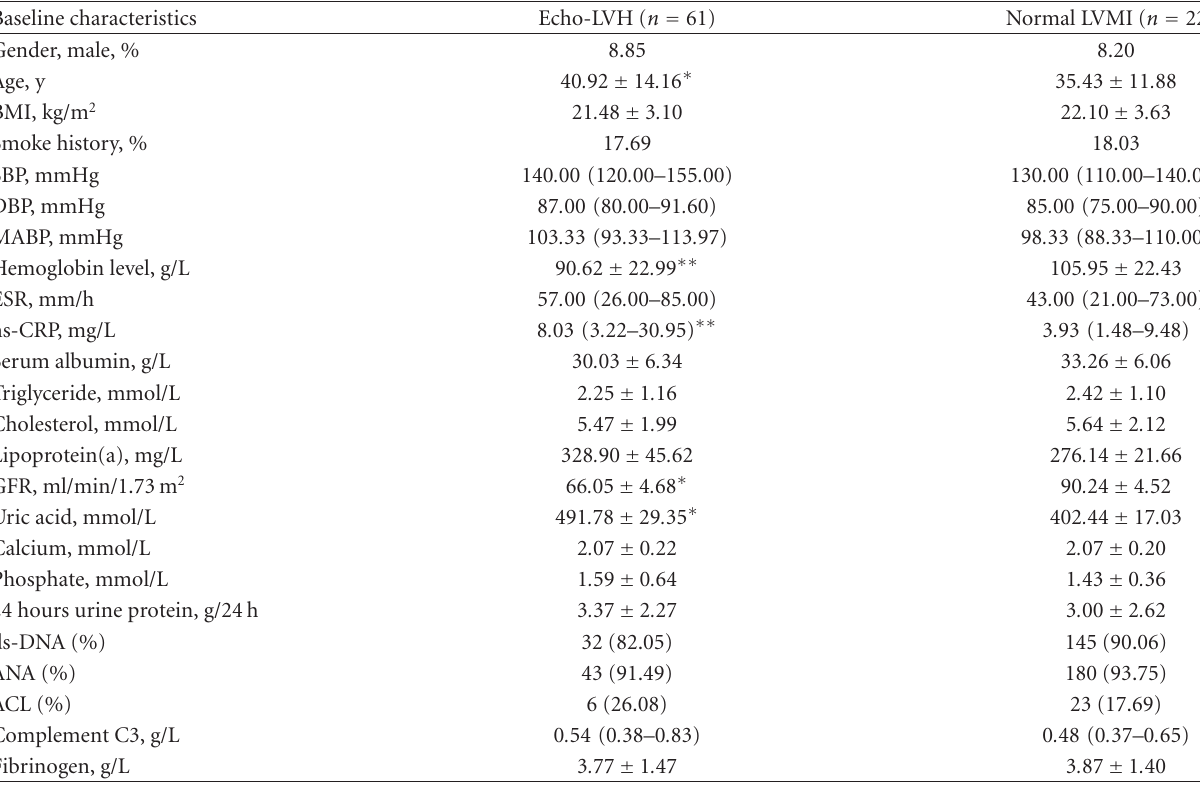
Table 1: Baseline characteristics of LN patients with and without echocardiographic